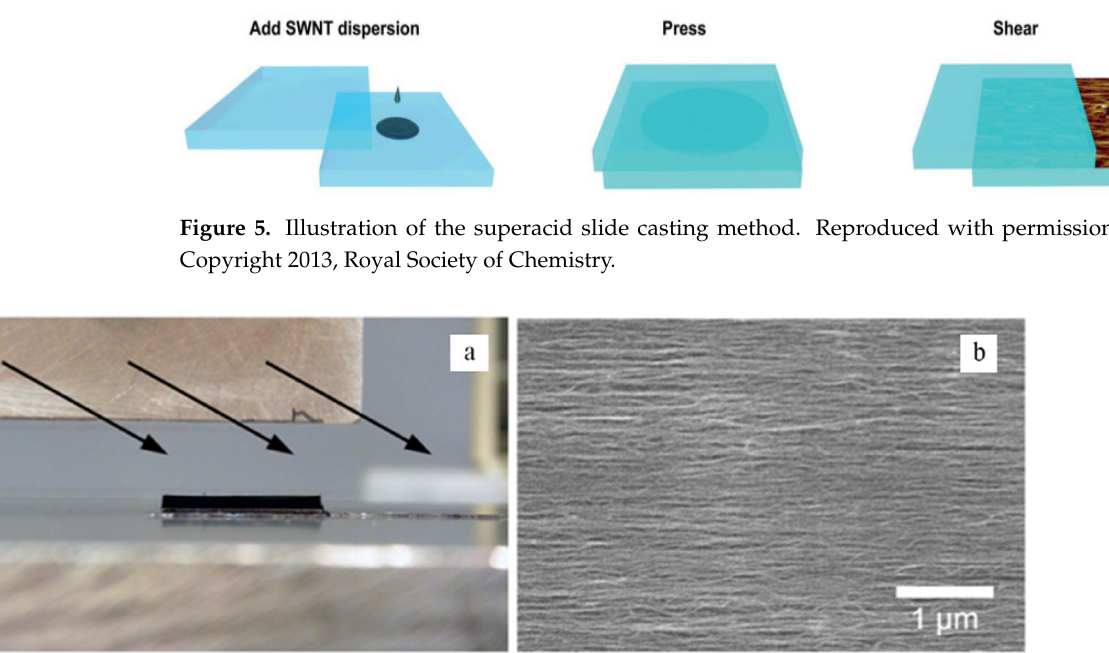
Figure 6. Overview of the process of shear pressing. ( a ) Process of shear pressing. ( b ) SEM image with aligned CNT after pressing. Reproduced with permission [62]. Copyright 2010, Elsevier.